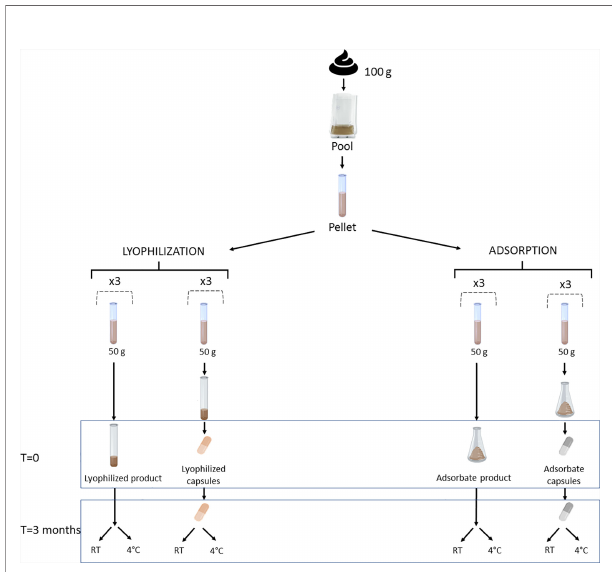
FIGURE 1 | Experiment design to compare bacterial viability in lyophilized and adsorbate capsules. Three replicates of each processing formulation were encapsulated, and three more were kept as lyophilized and adsorbate products. The analysis was performed in each aliquot at time point 0 and 3 months after being stored at room temperature (RT) and at 4°C. Created with